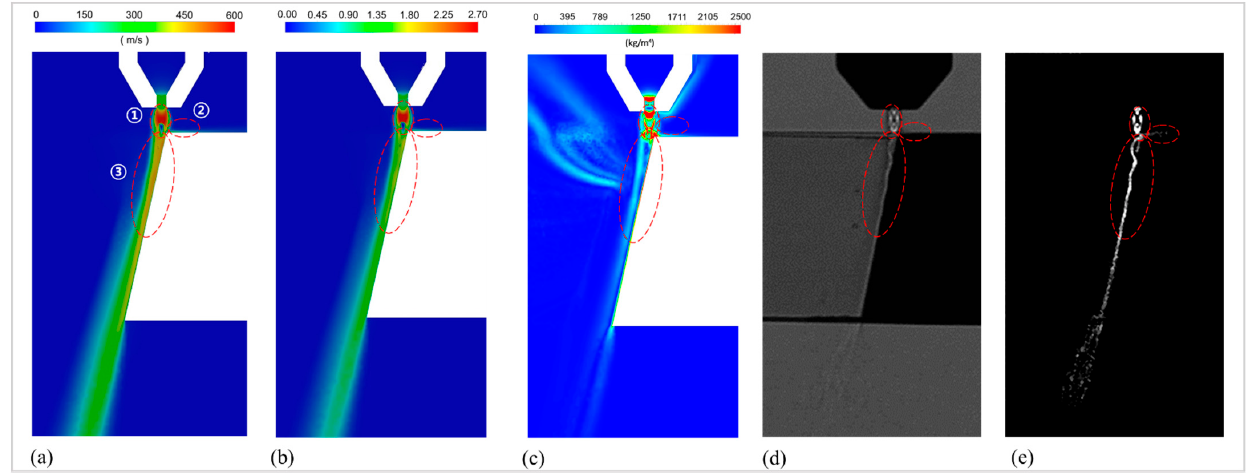
Figure 15. Comparison of flow pattern. ( a ) Numerical simulation result for k– ω turbulence model (velocity field), ( b ) numerical simulation result for k– ω turbulence model (Mach number), ( c ) numerical simulation result for k– ω turbulence model (density gradient), ( d ) Schlieren experiment result, and ( e ) image processed result.